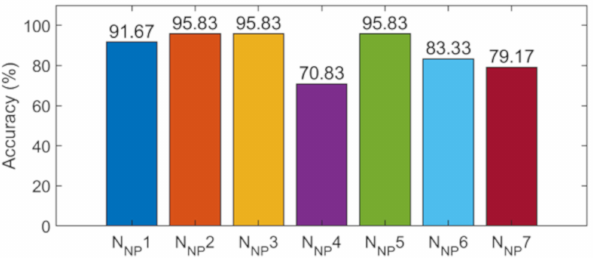
Figure 13. Detection results of the testing samples using 7 networks.